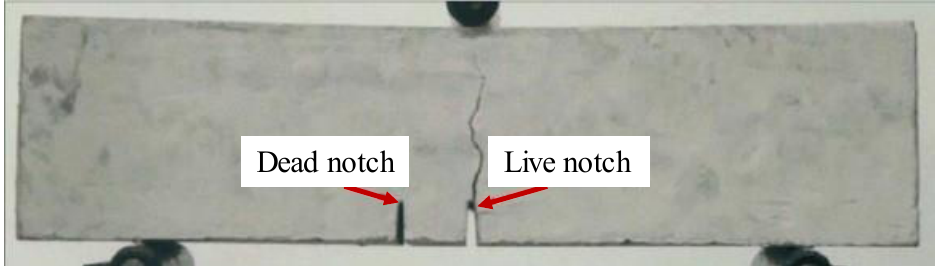
Figure 13. Experimental fracture feature of a double-notched concrete beam from [54].